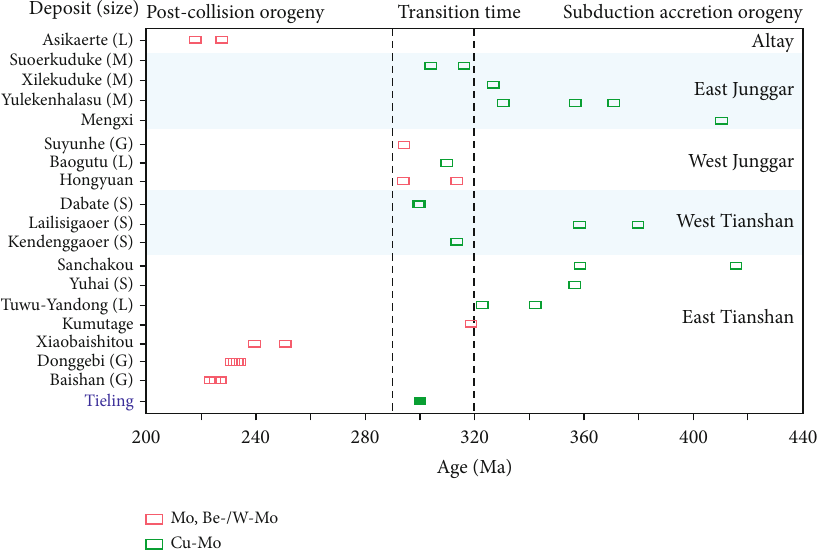
Figure 14: Re-Os isotopic ages from the Mo deposits in northern Xinjiang, NW